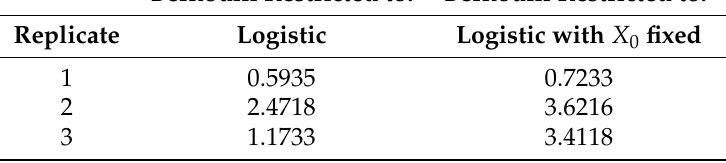
Table 2. Model comparison ˆ u n scores for the continuous Logistic model compared to Bernoulli model for each replicate. We also chose to fix the initial condition X 0 at the seed population value to enunciate model improvement if X 0 was unalterable. Note that values less than 2.706 indicate the restricted model is